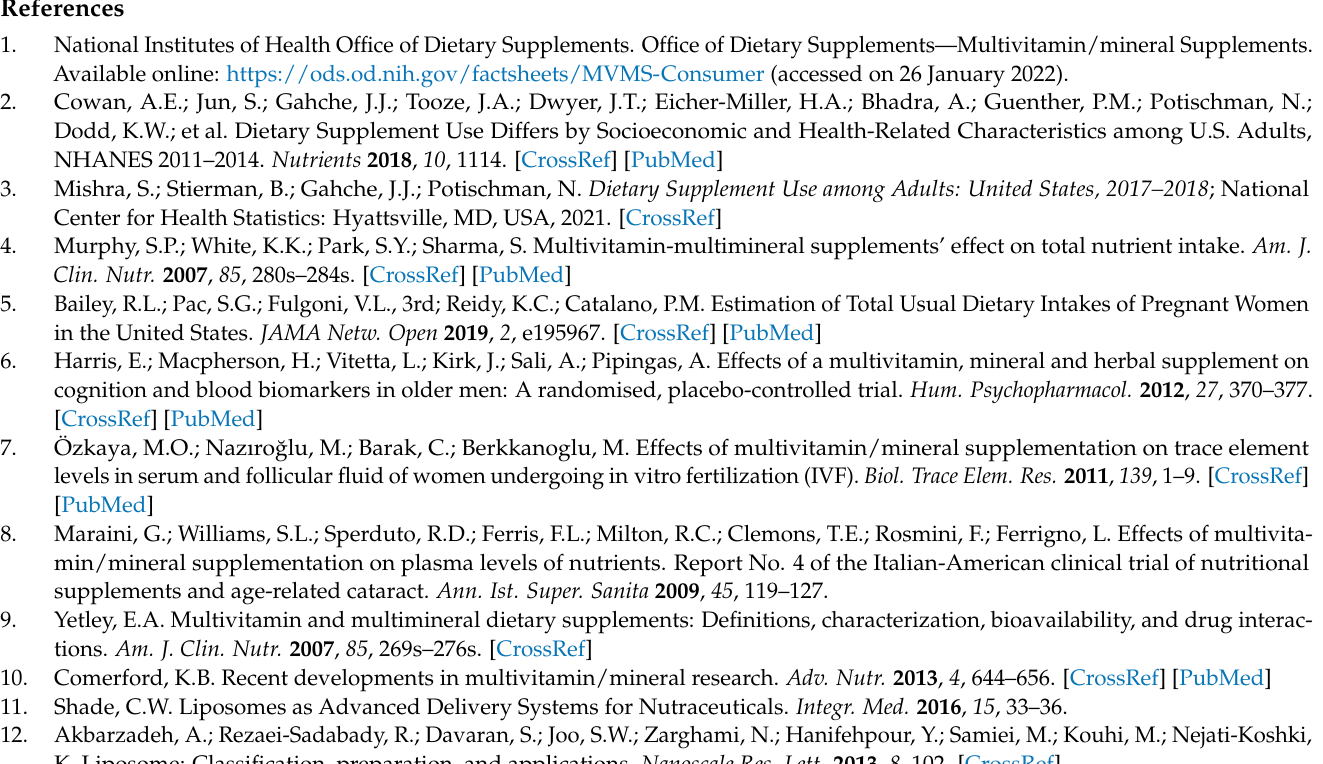
Figure A2. Raw Magnesium Concentrations. No significant condition * time interaction was observed for raw magnesium concentrations, uncorrected for baseline values, in the full sample ( A ) or in a sensitivity analysis with extreme outliers removed ( B ). A significant condition * time * sex interaction was observed in the sensitivity analysis (Table A1); however, follow-up testing did not reveal any statistically significant pairwise comparisons. Due to variation in raw baseline concentrations between conditions, the raw changes presented above are viewed as supplemental/secondary, while changes from the baseline and pharmacokinetic parameters (i.e., iAUC) were the primary